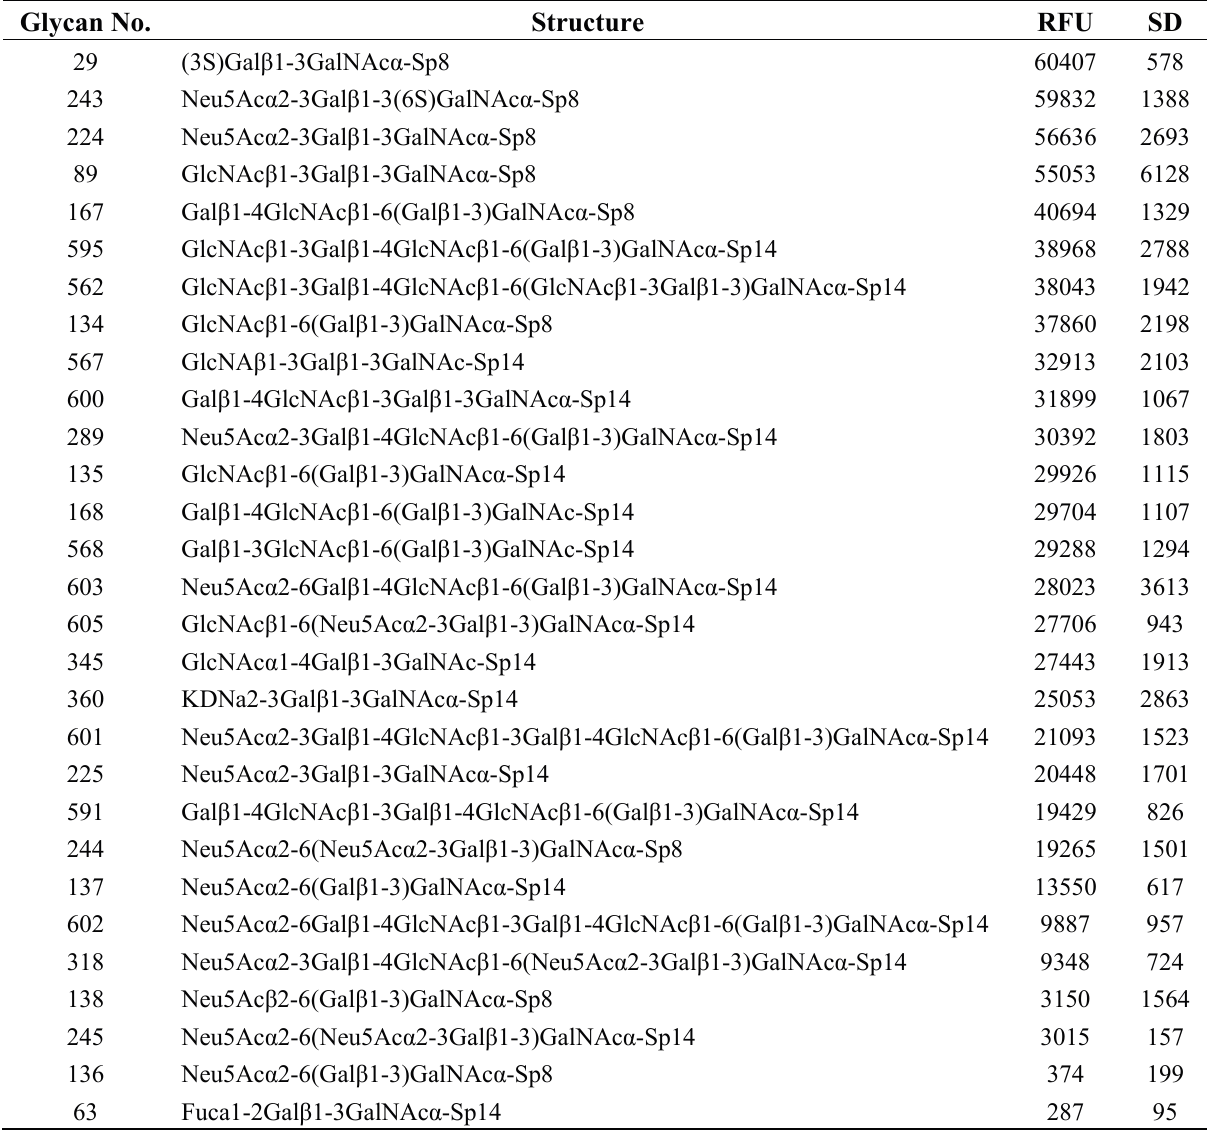
Table 4. Binding affinity of SSR1 towards TF disaccharide and its substituted forms. Glycan